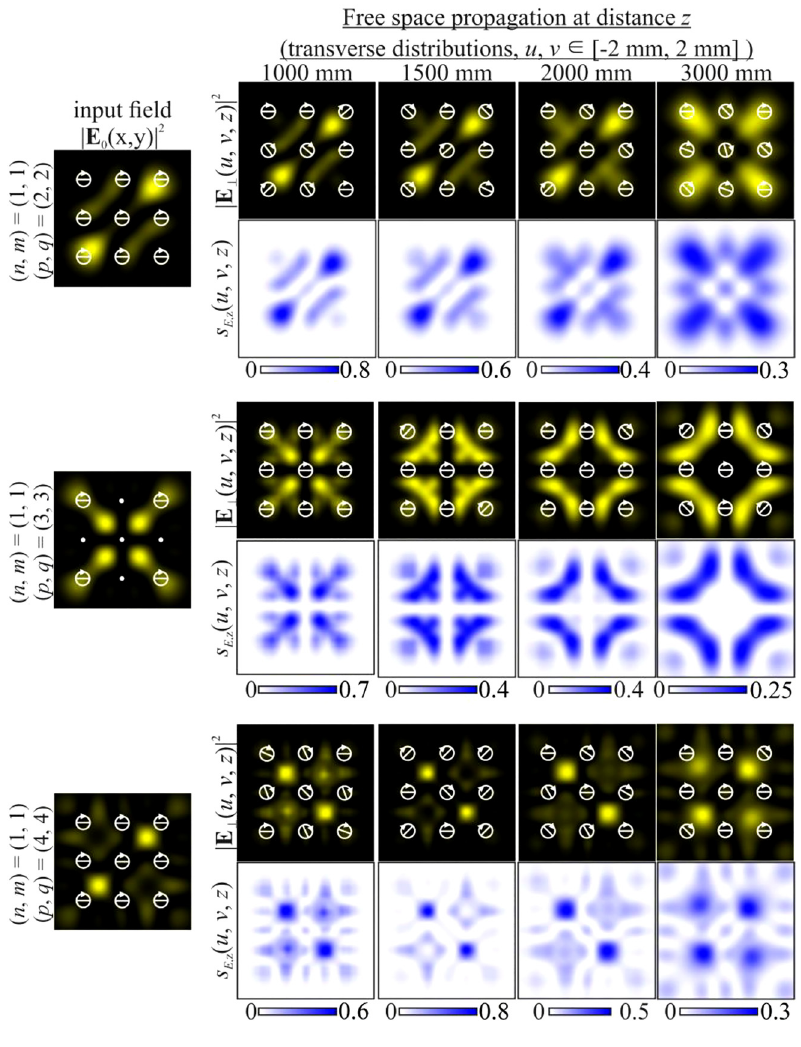
Figure 1: Propagation of uniformly polarized ( “ + ” -circular polarization) two-mode HG beams de fi ned by Eq. (26) with indices ( n + m ) ≠ ( p + q